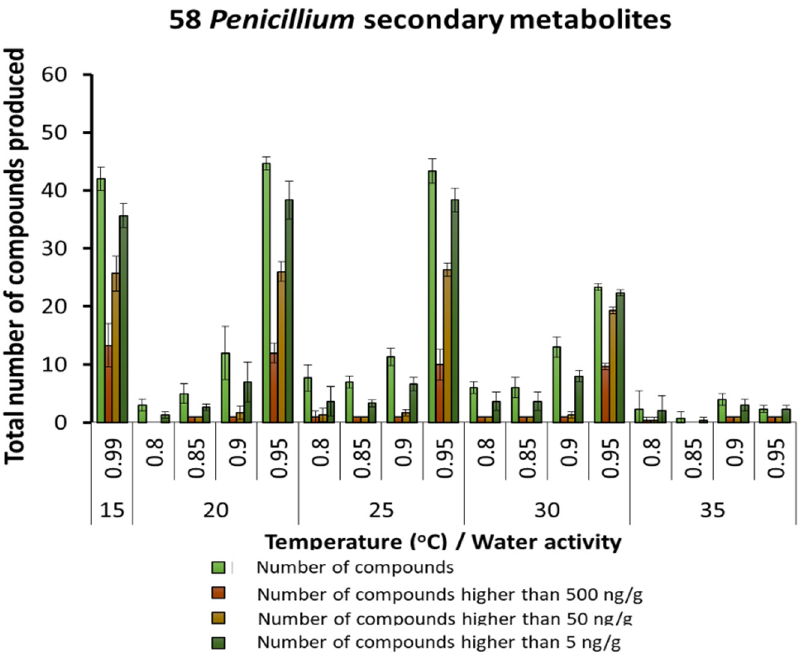
Figure 4. Summary of the predominant secondary metabolites detected in maize produced by species of the Penicillium genus stored under different temperature × water activity conditions. Bars represent the Standard Error of the mean.